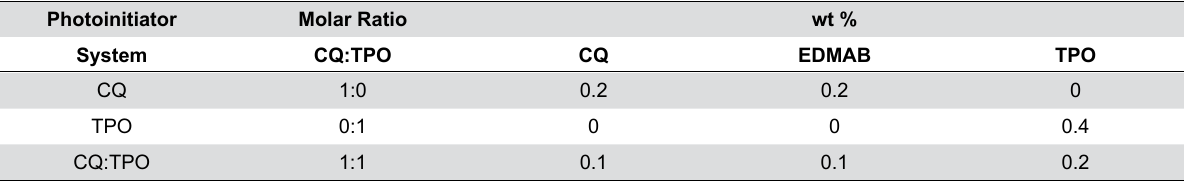
Table 2- Photoinitiator systems Photoinitiator